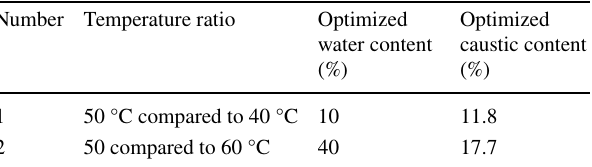
Table 7 Percentage of optimized water and caustics at the optimum temperature